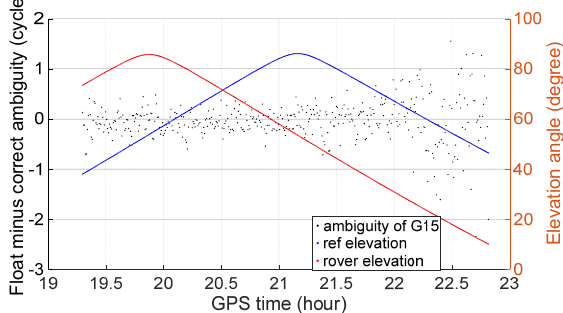
Figure 4. Ambiguity resolution of wide lane G15.